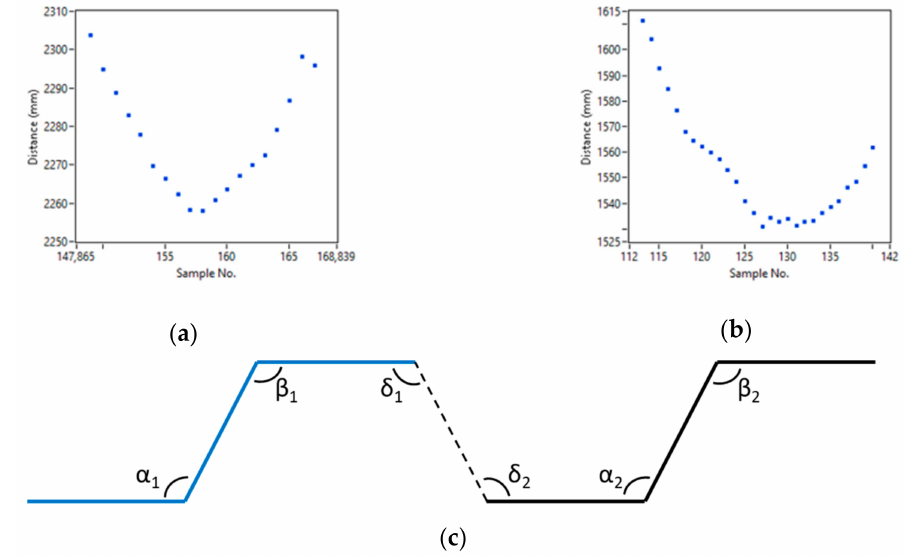
Figure 14. Samples of the legs scanline ( a ) left leg, ( b ) right leg, and ( c ) polylines